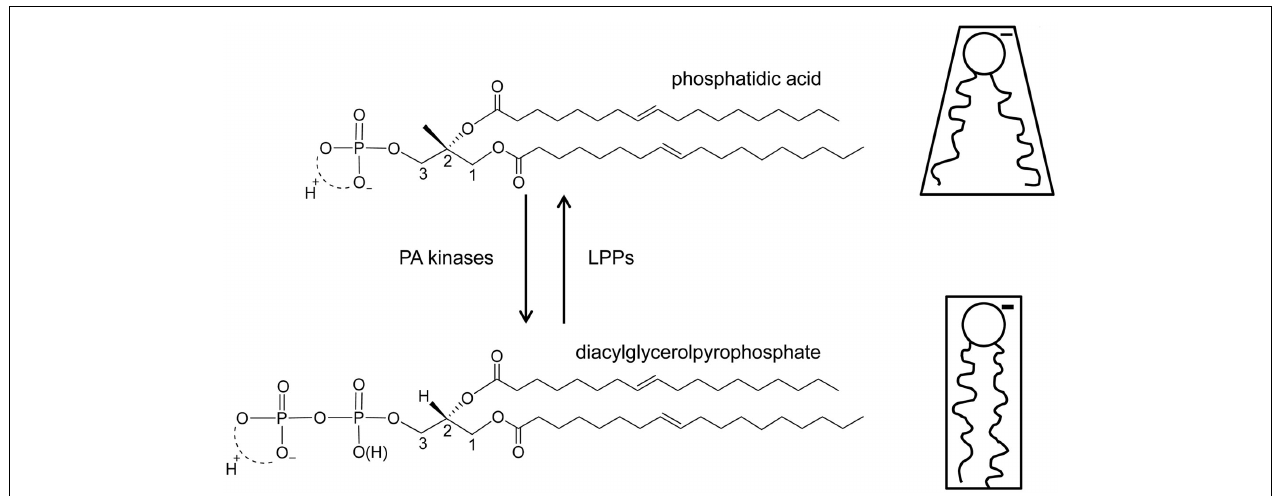
the effective molecular shape of PA and DGPP at physiological pH and salt (NaCI) concentration is shown.The negative charge of both PA and DGPP is shown. In similar membrane environments (lipid composition) and under physiological conditions DGPP carries more negative charge then PA as indicated by the thicker